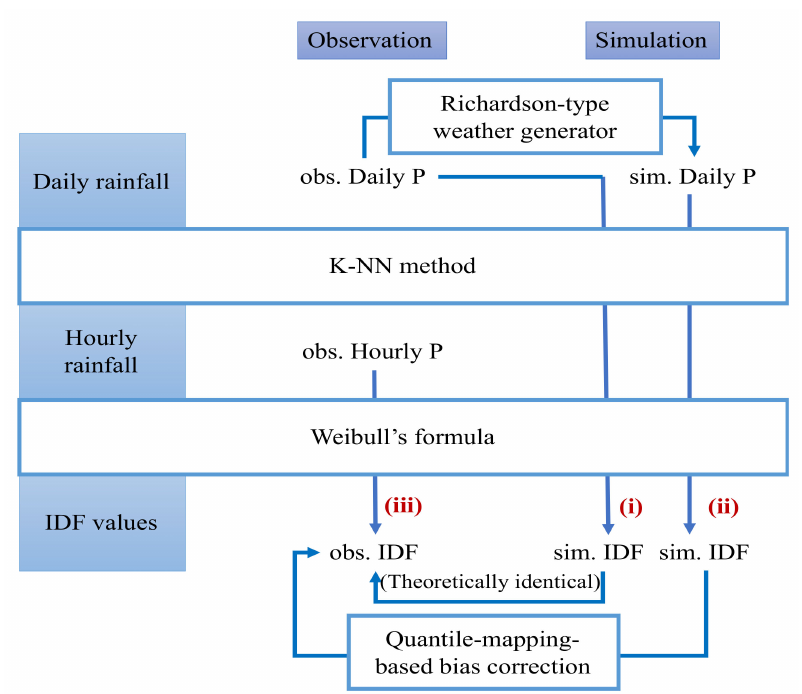
Figure 2. Relation between the IDF values in the historical period (1986–2005) used to verify the reliability of the K-NN method, derived based on (i) the observed daily rainfall, (ii) the projected daily rainfall, and (iii) the observed hourly